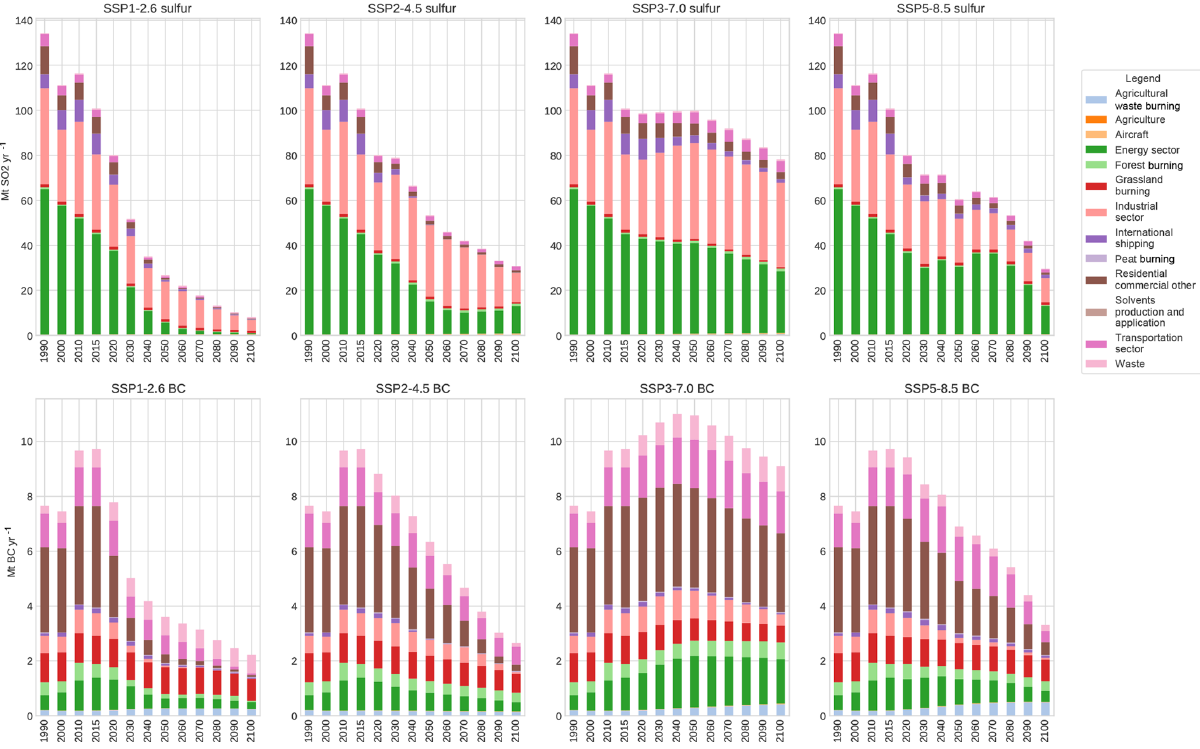
Figure 6. The sectoral contributions to sulfur and black carbon emissions for Tier-1 scenarios.